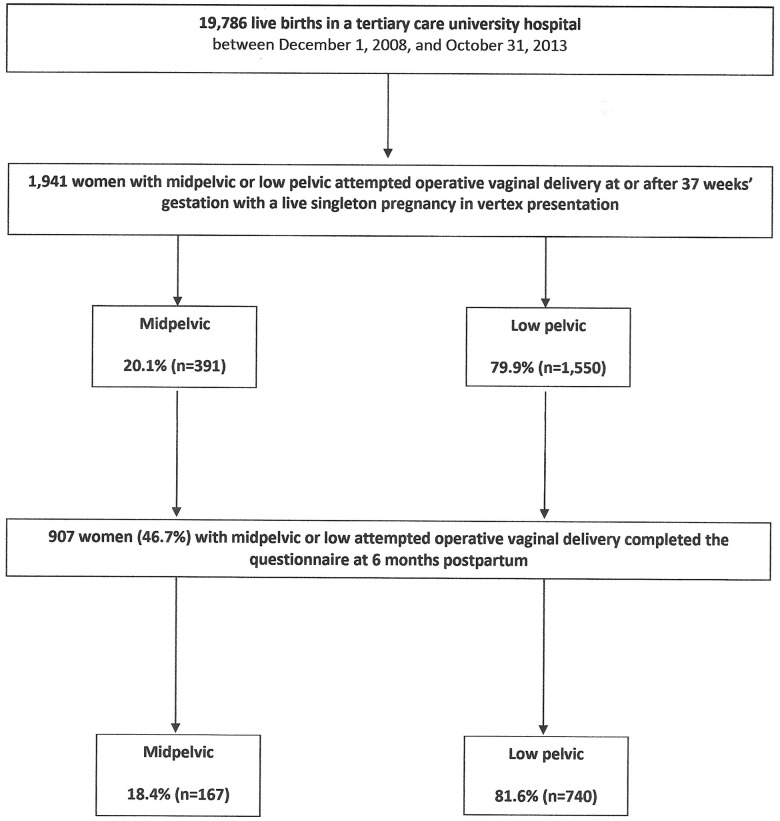
Cohort flowchart.